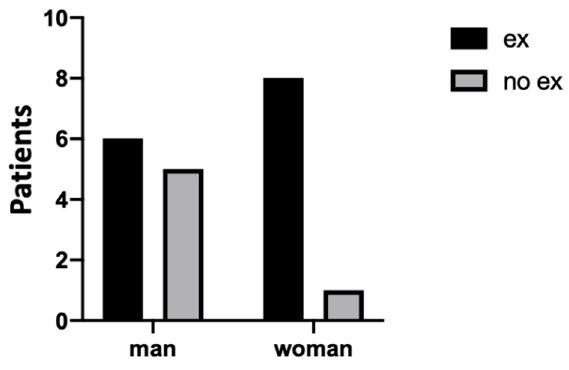
Figure A3. Bleeding of gums before and after hospitalization of the patients. No statistical difference was shown between the study time points ( p > 0.99).